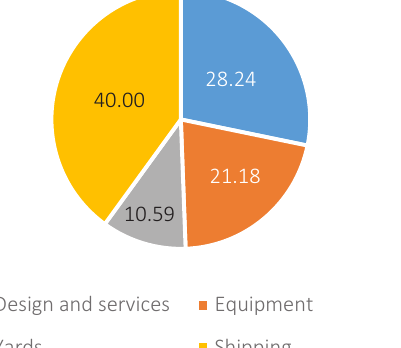
Source: Menon/SSB